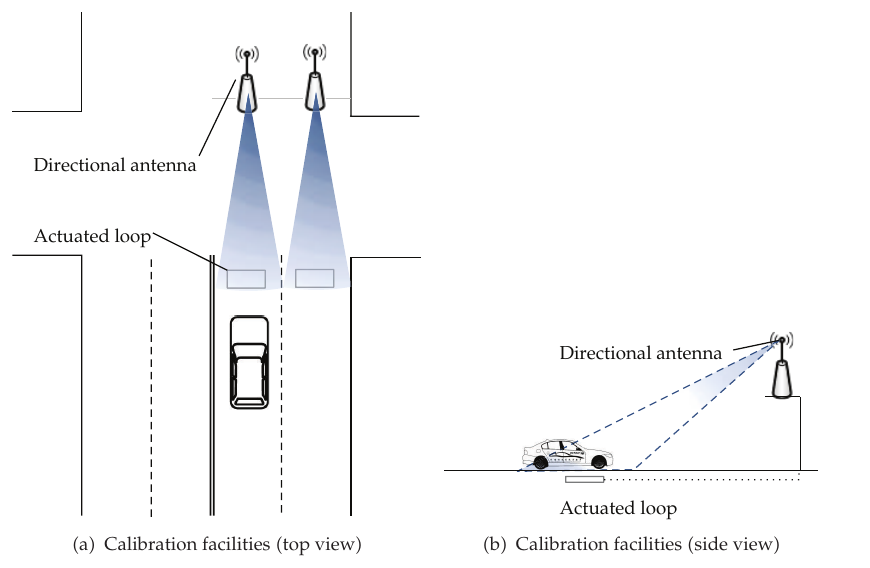
Figure 8: Calibration